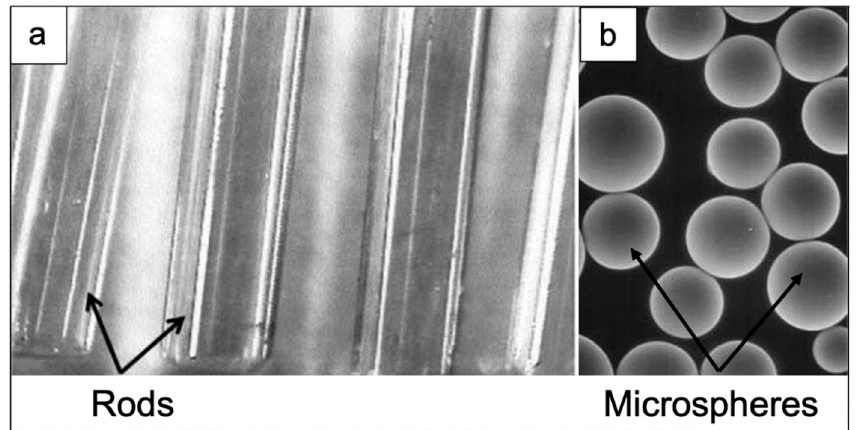
Figure 5. REAS glasses with different shapes: ( a ) rods and ( b ) microspheres, used in brachytherapy. The rods in ( a ) and the glass microspheres in ( b ) were based on the 46.8Sm 2 O 3 -18.2Al 2 O 3 -35SiO 2 (wt.%) and 55Y 2 O 3 -20Al 2 O 3 -25SiO 2 (wt.%) systems, respectively. Rods in figure ( a ) have a diameter of 1 mm, while the spheres depicted in figure ( b ) exhibit a diameter ranging between 20–30 µ m